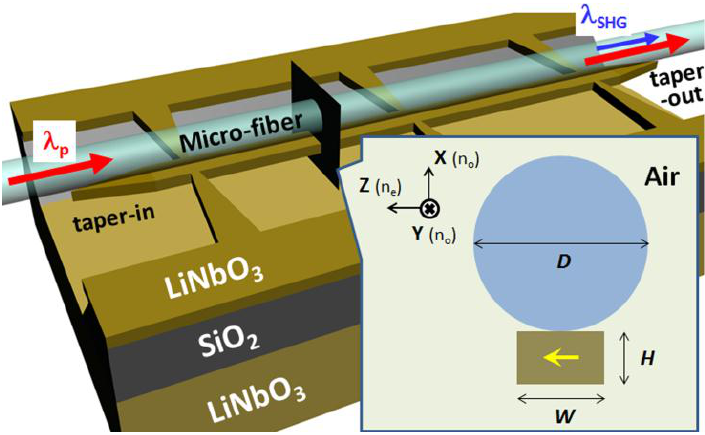
Figure 1. Schematic view of the microfiber-lithium niobate on insulator (MF-LNOI) hybrid waveguide. The optic axis of LN crystal is indicated by the yellow